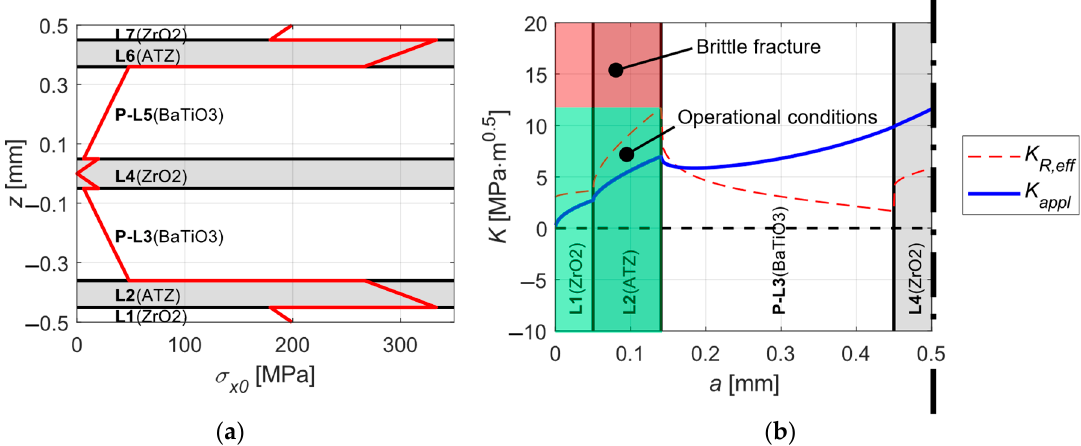
Figure 15. ( a ) Amplitude of the bending stress within the laminate kinematically excited with an amplitude of 0.9 g. ( b ) Stress intensity factor K appl (blue solid curve) corresponding to excitation amplitude 0.9 g and the apparent fracture toughness K R,eff (red dashed curve); brittle fracture of the whole structure occurs if K appl > K R,eff in ATZ layer, i.e., if the blue solid curve appears in the red-filled area.